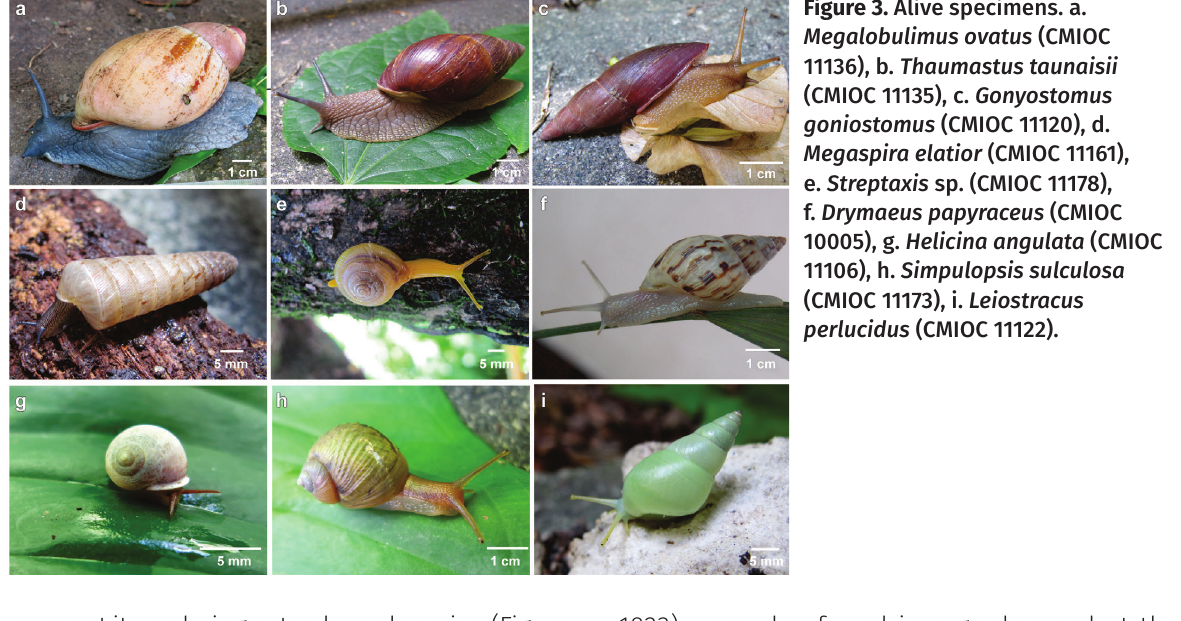
Figure 3. Alive specimens.